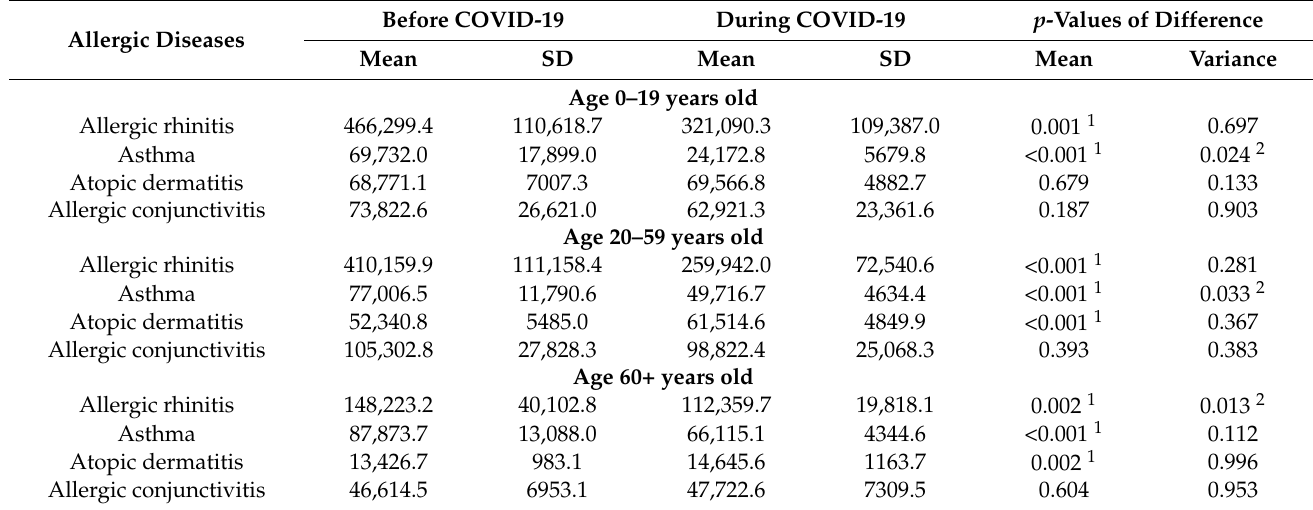
Table 3. Monthly numbers of patients treated for allergic diseases before and during the COVID-19 pandemic and the differences in the subgroups divided by